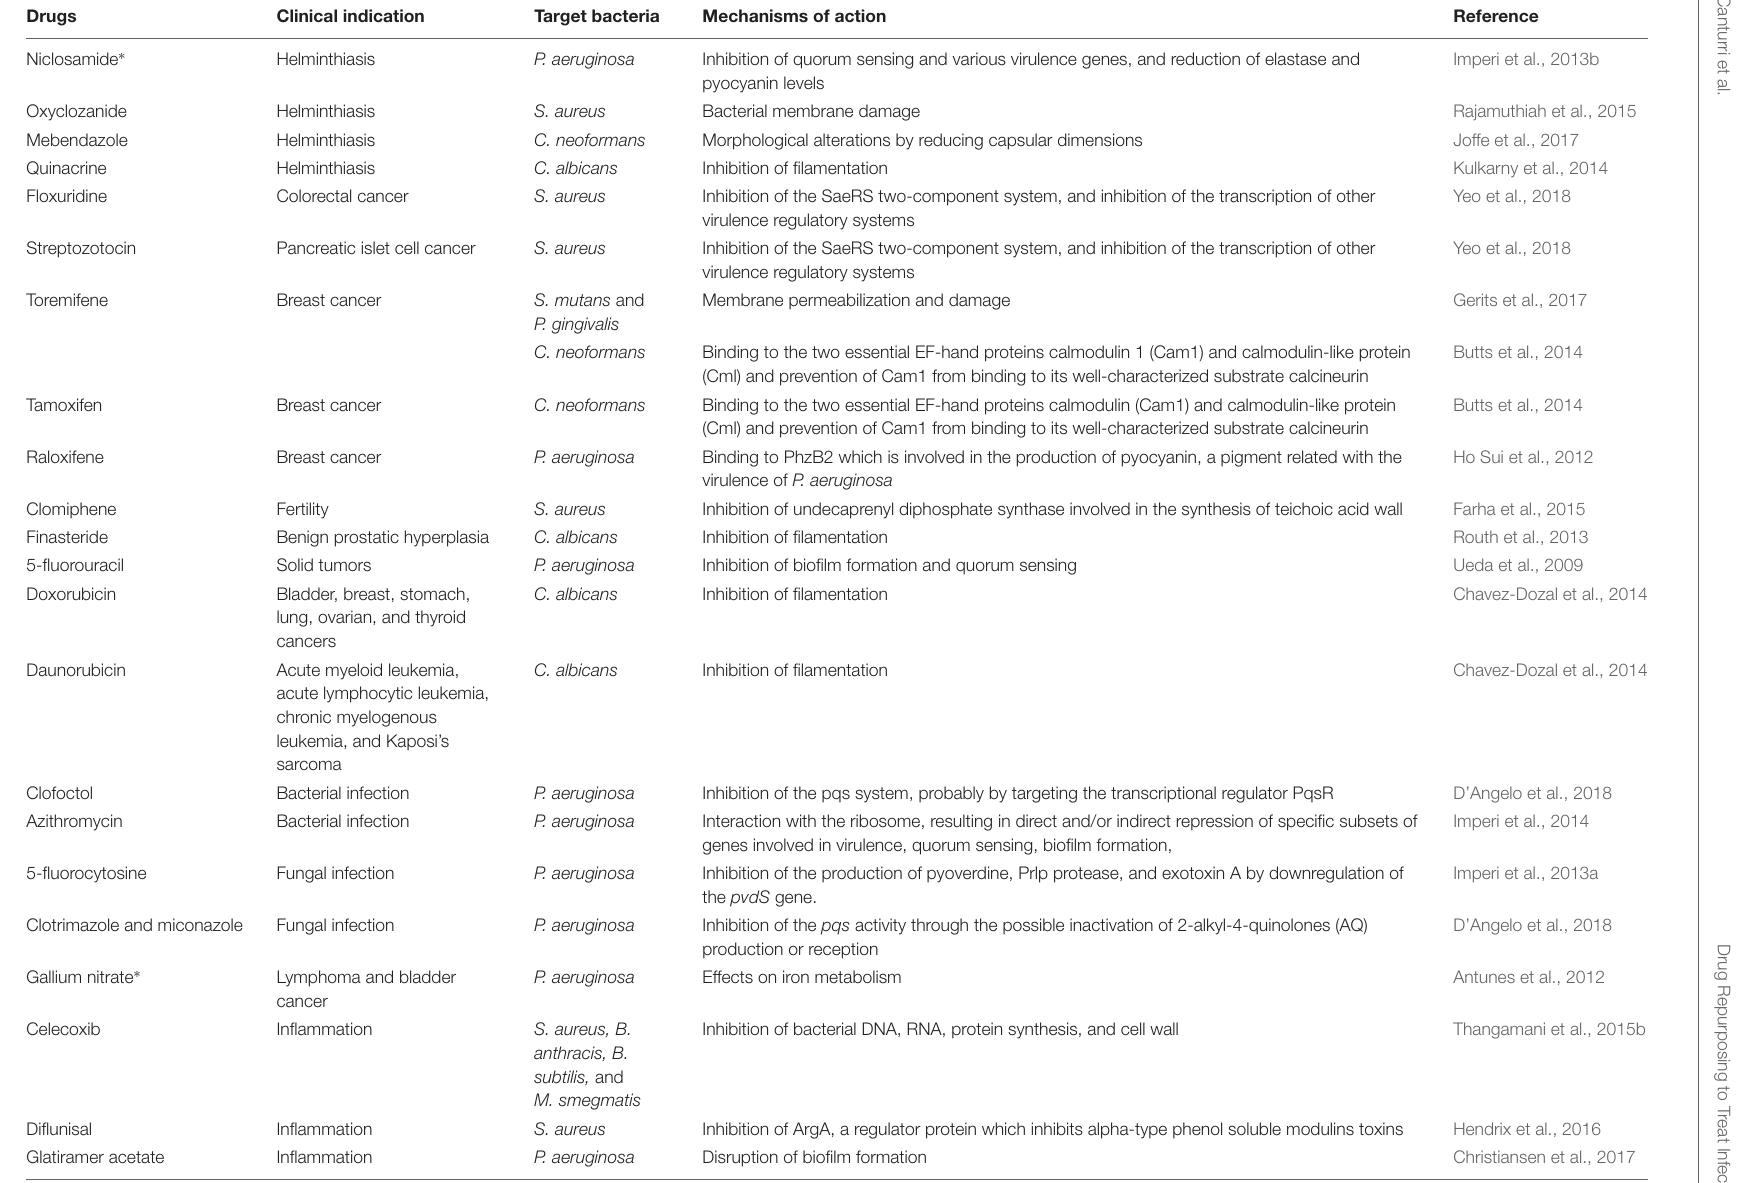
TABLE 1 | Direct antibacterial and antifungal activity of repurposed drugs.